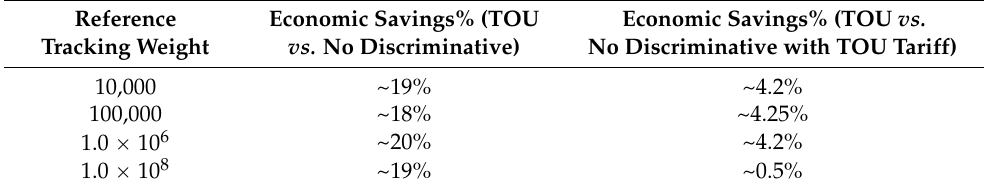
Table 6. Economic savings in February between Time of Use (TOU) and no discriminative tariff (Table 5) for different weight relations between reference tracking and energy